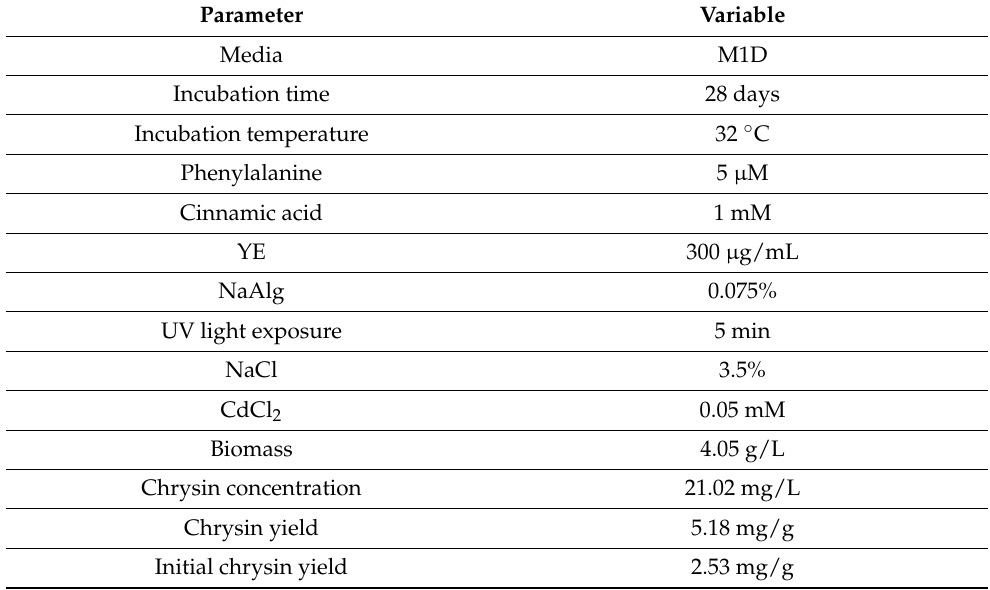
Table 3. Verification of optimized fermentation conditions, precursors, and elicitors for enhanced chrysin